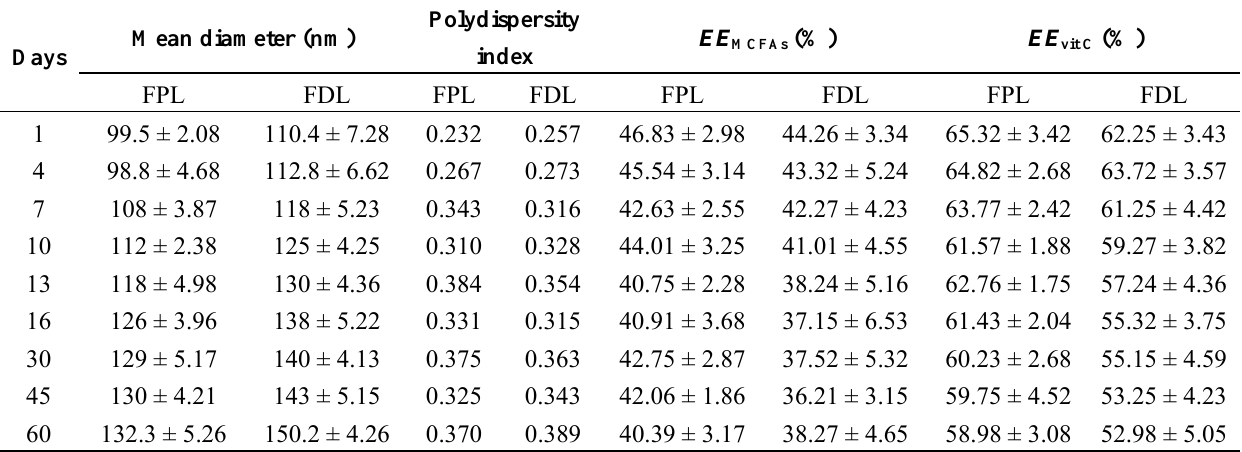
Table 2. Characteristics of MCFAs-vit C complex nanoliposomes during storage at 4